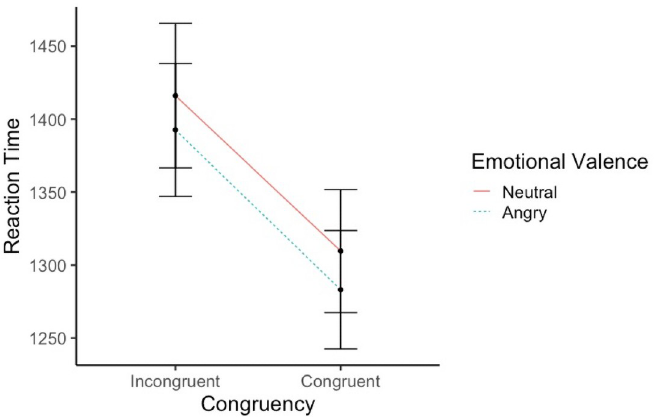
Fig 2. Changes in reaction times as a function of congruency and emotional value.